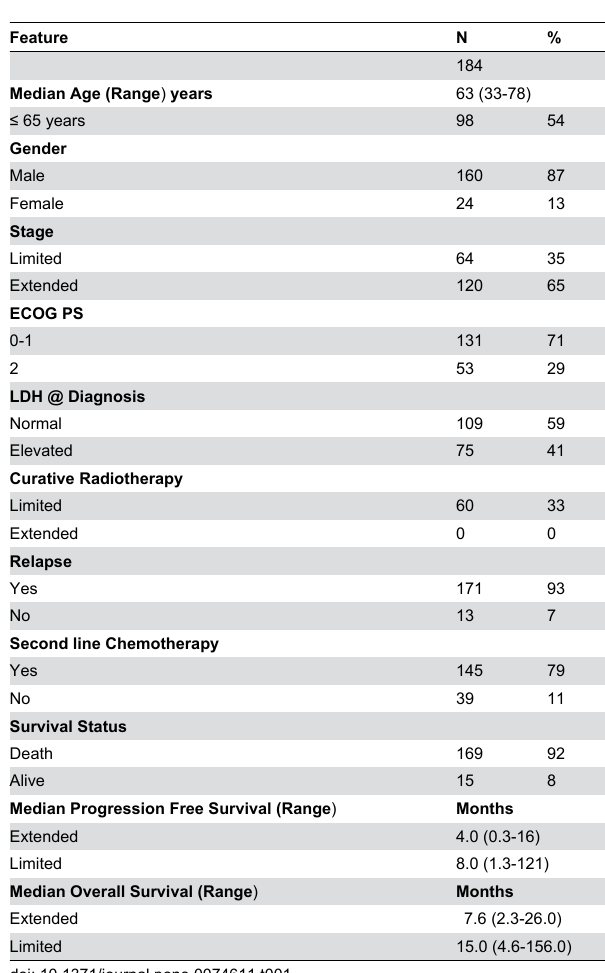
Table 1. Patients’ and tumours’ characteristics.